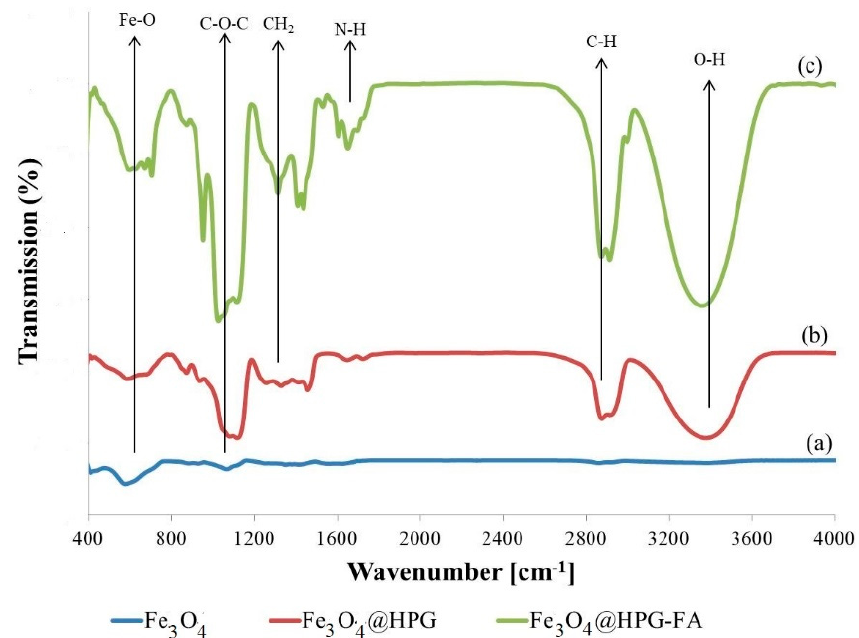
Figure 1. FT-IR spectroscopy of ( a ) Fe 3 O 4 ( b ) hyperbranched polyglycerol (HPG) grafted Fe 3 O 4 and ( c ) Fe 3 O 4 @HPG-FA .